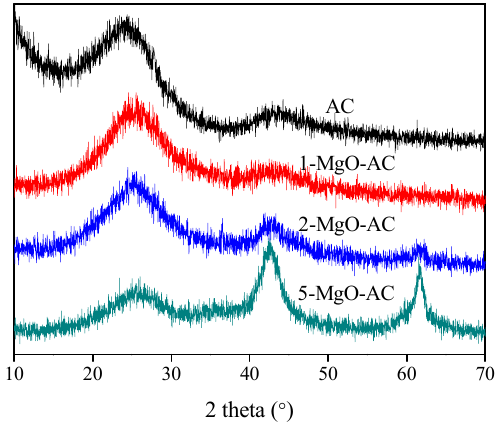
Figure 3. XRD patterns of bare AC and MgO-coated AC samples.